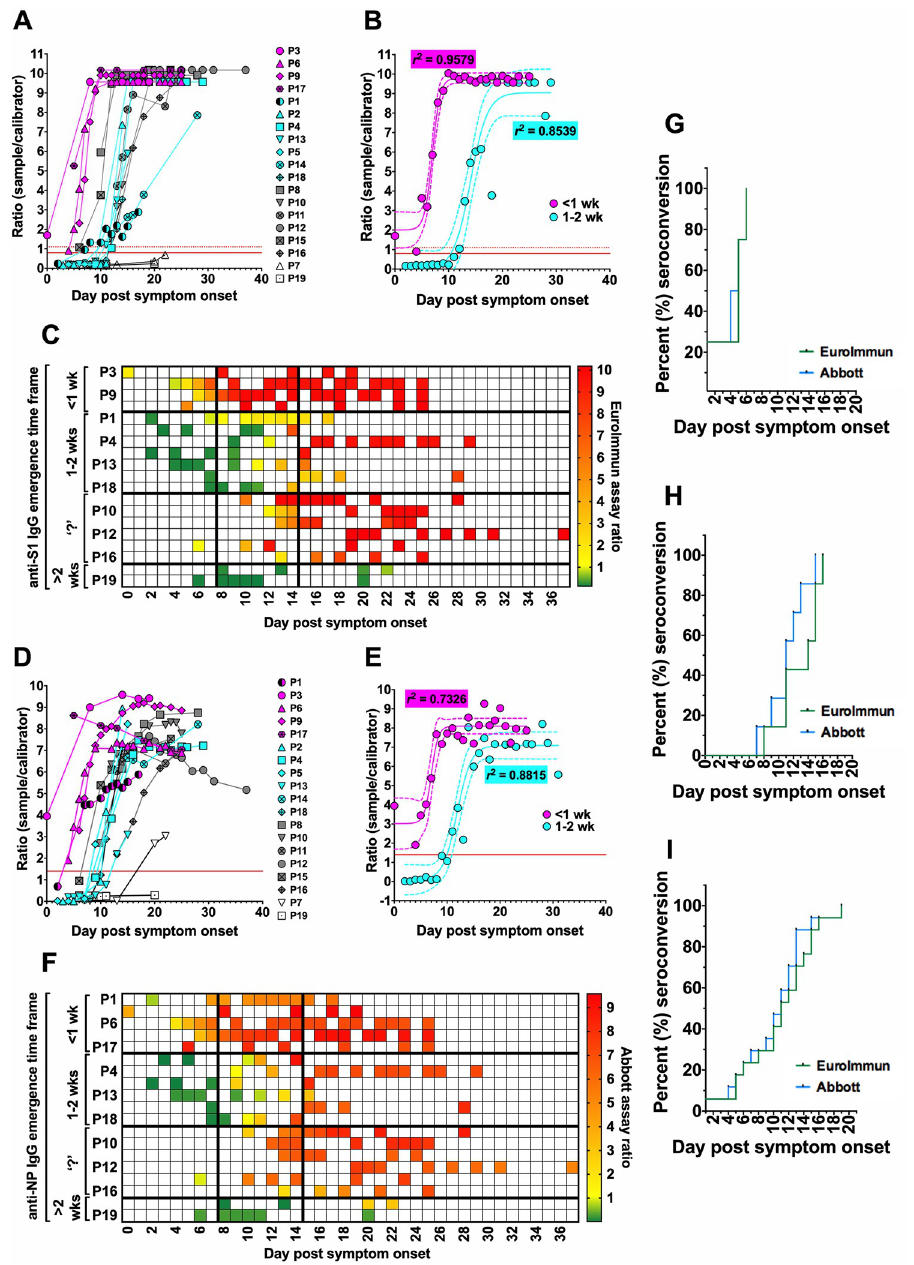
Fig 1. Temporal emergence of anti-S1 and anti-NP IgG amongst the cohort members. Serum samples collected from the cohort members over time were analysed for IgG against the major SARS-CoV-2 antigens. ( A ) Individual time course data for anti-S1 IgG emergence, and (B) best-fit curves for anti-S1 IgG responses occurring after < 7 days or between 7–14 days pso. Cut-offs for negative (ratio 0.8) and positive (ratio 1.1) seroreactivity in the EuroImmun assay are depicted by solid red line and dashed red line, respectively. ( C ) Data from A presented as a heat-map. ( D — F ) As in A-C , but for anti-NP IgG emergence. The cut-off (ratio 1.4) for negative/positive seroreactivity in the Abbott assay depicted in solid red line. Patient #1 was considered an outlier and was therefore excluded from all best-fit curve analyses. In B and E —dashed trend lines indicate 95% CI ranges; and r 2 values describe tightness of fit. In C and E —‘?’ indicates undetermined seroconversion time frame. Kaplan-Meier curves comparing the seroconversion detection by the EuroImmun and Abbott assays amongst ( G ) the seroconverted, ( H ) those where seroconversion was observed, and ( I ) all cohort members